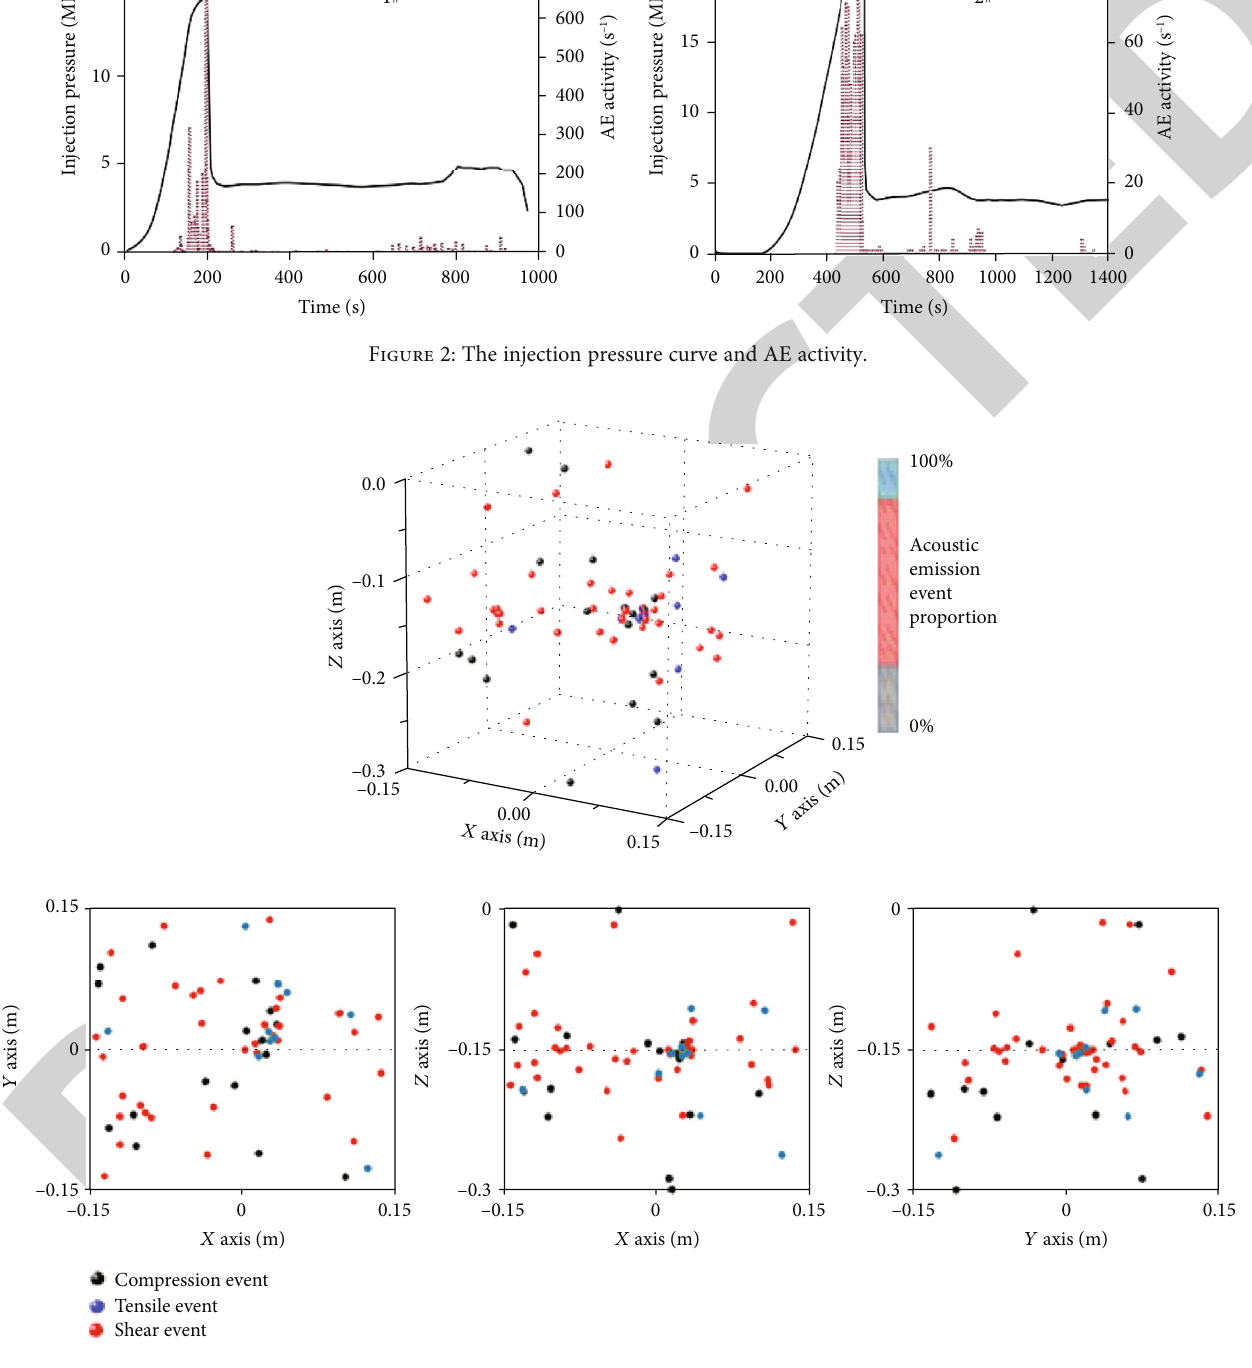
Figure 3: The AE event distribution of Sample